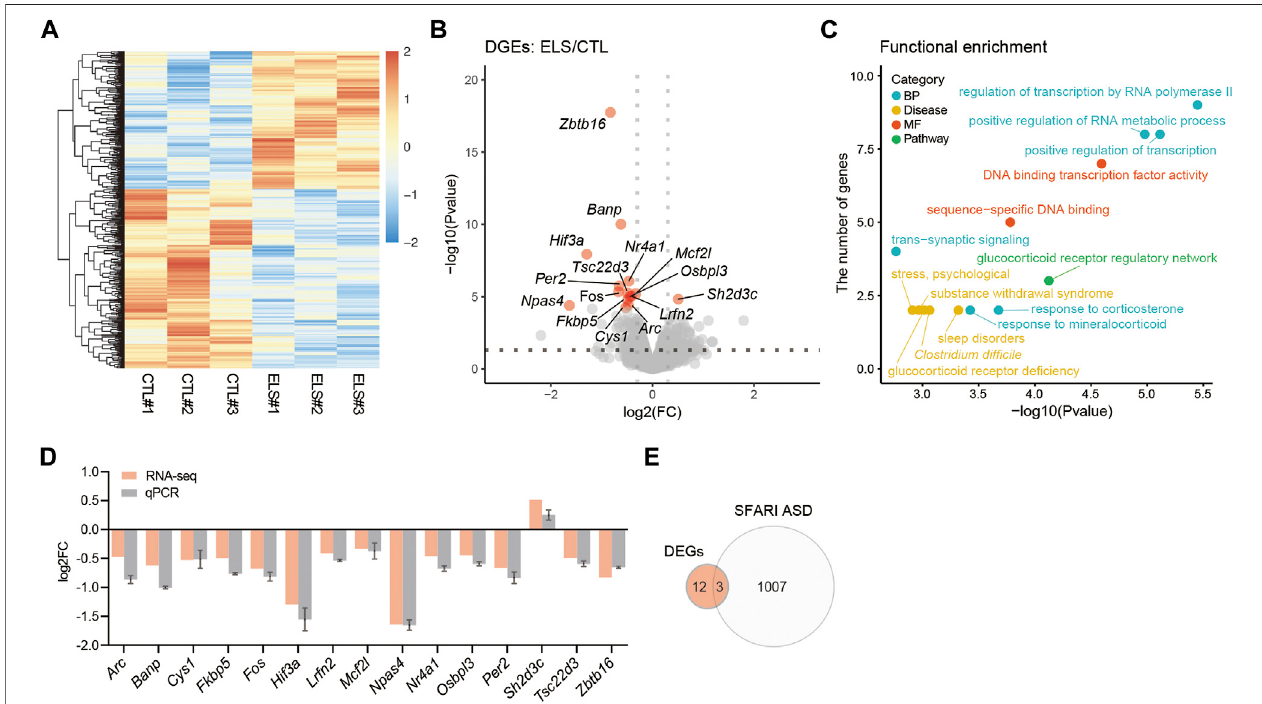
FIGURE5| Transcriptomic alteration inthePFCofELSmice. (A) Heatmap ofgeneexpressions inthePFC. (B) Volcano plotsshowingELSdifferentially expressed genes (DEGs). FDR < 0.05. X-axis (cid:2) − log10(Pvalue), Y-axis (cid:2) log2(FC). FC, fold change. (C) Scatter plots represent functional enrichment of ELS DEGs in biological process (BP), disease, molecular function (MF), and pathway. X-axis (cid:2) − log10(Pvalue), Y-axis (cid:2) the number of genes. p -Values reported by FDR < 0.05 threshold. (D) qPCR con fi rmation of ELS DEGs expressions in the PFC. (E) Venn diagram of ELS DEGs overlapping with SFARI autism spectrum disorder (ASD) genes. The overlapping 3 genes are Zbtb16, Per2, and Lrfn2 . n (cid:2) 3/condition for